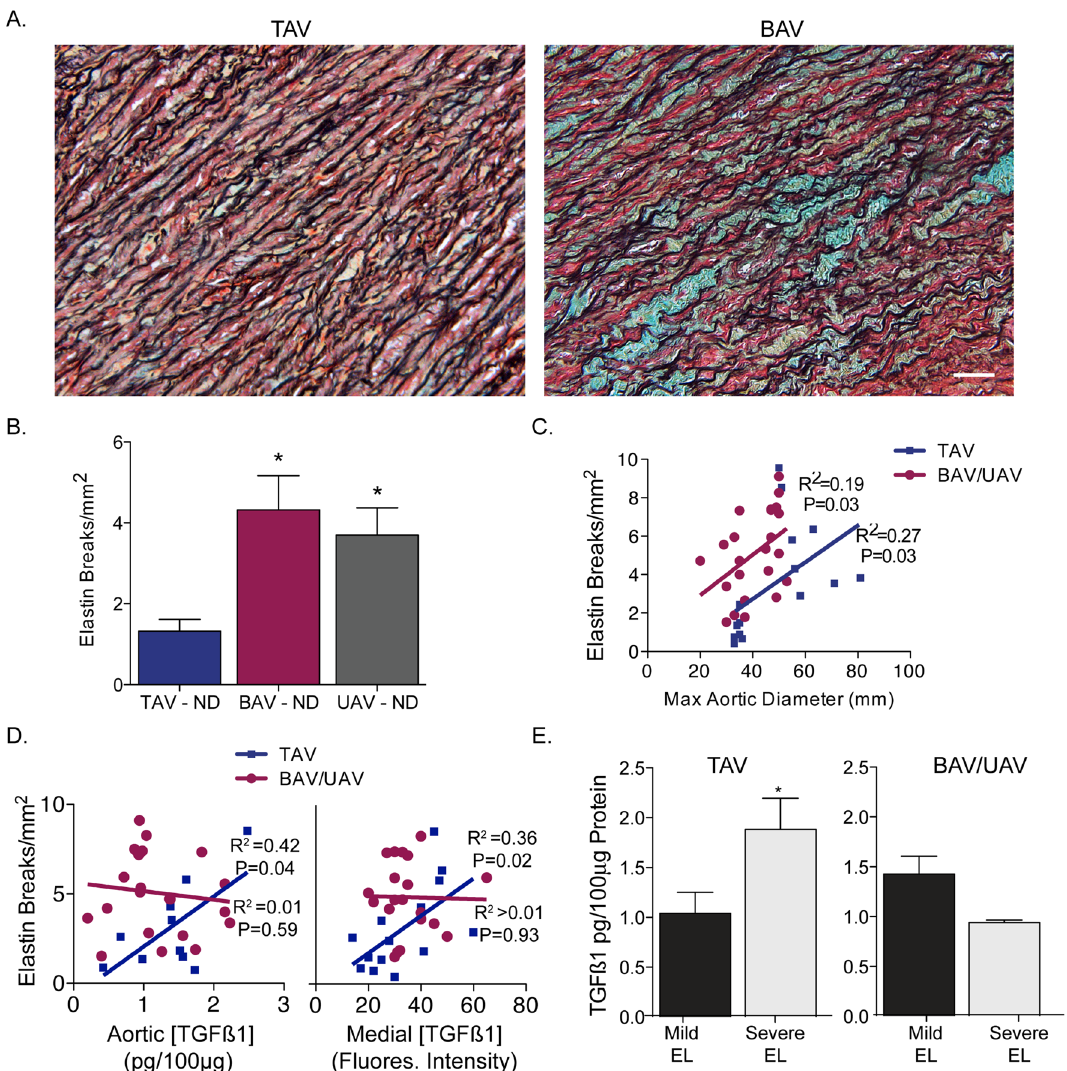
Figure 5. Elastin degradation is dependent upon transforming growth factor-beta ligand in tricuspid (TAV), but not bicuspid (BAV) or unicuspid (UAV) aortic aneurysms. ( A ) Photomicrographs of ascending aortic cross-sections labeled with Movat’s pentachrome, depicting elastin (black filaments) breaks and degradation in BAV aortas. Blue stain represents mucoid extracellular matrix deposition. ( B ) Graph depicting elastin breaks in non-dilated (ND) aortas from individuals with a TAV, BAV or UAV. ( C ) Graph depicting the relationship between elastin breaks and maximal ascending aortic diameter in TAV (blue) and BAV/UAV (pink) aortas. ( D ) Graphs depicting the relationships between TGFß1 ligand concentration (whole aorta: left, medial layer: right) and elastin breaks in TAV (blue) and BAV/UAV (pink) aortas. ( E ) Graphs depicting the TGFß1 ligand concentration in ascending aortas with mild elastin loss (EL) and severe EL for TAV (left) and BAV/UAV (right) aortas. *P < 0.05. Scalebar = 50 µm. Fluores. =